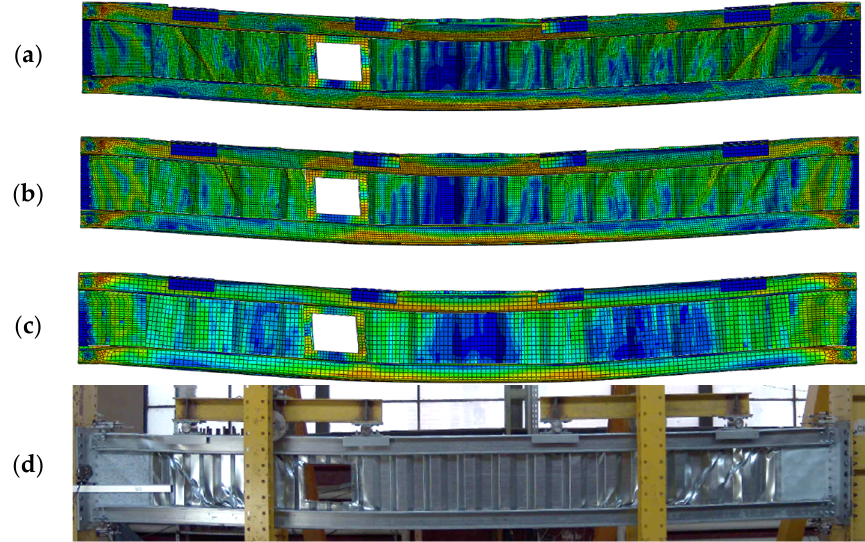
Figure 12. Comparison of Von Misses stresses for ( a ) a mesh size of 10 mm, ( b ) a mesh size of 15 mm, ( c ) a mesh size of 30 mm, and ( d ) the experiment [40]. ( c ) a mesh size of 30 mm, and ( d ) the experiment